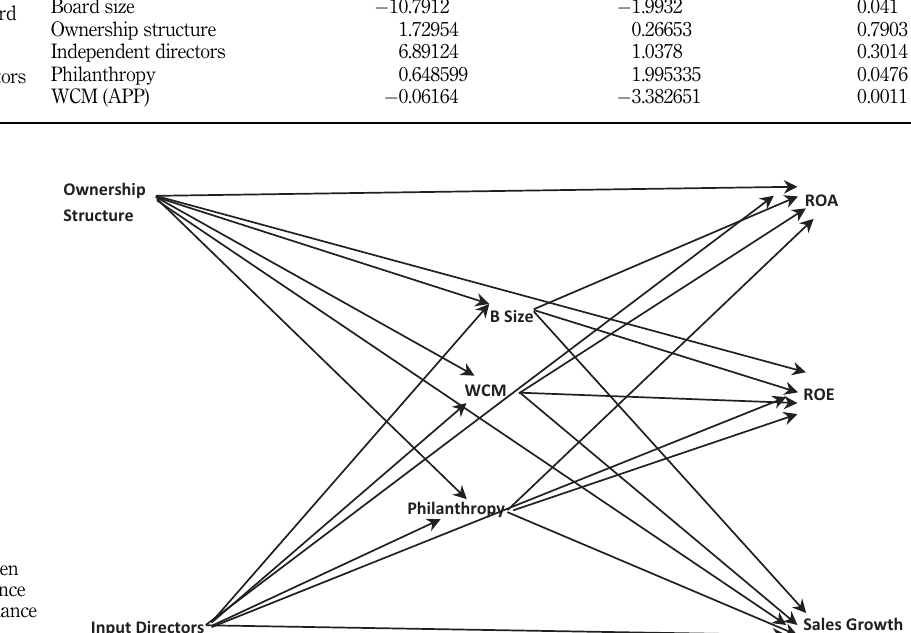
Table 3. The impact of board size, ownership structure and independent directors on sales growth